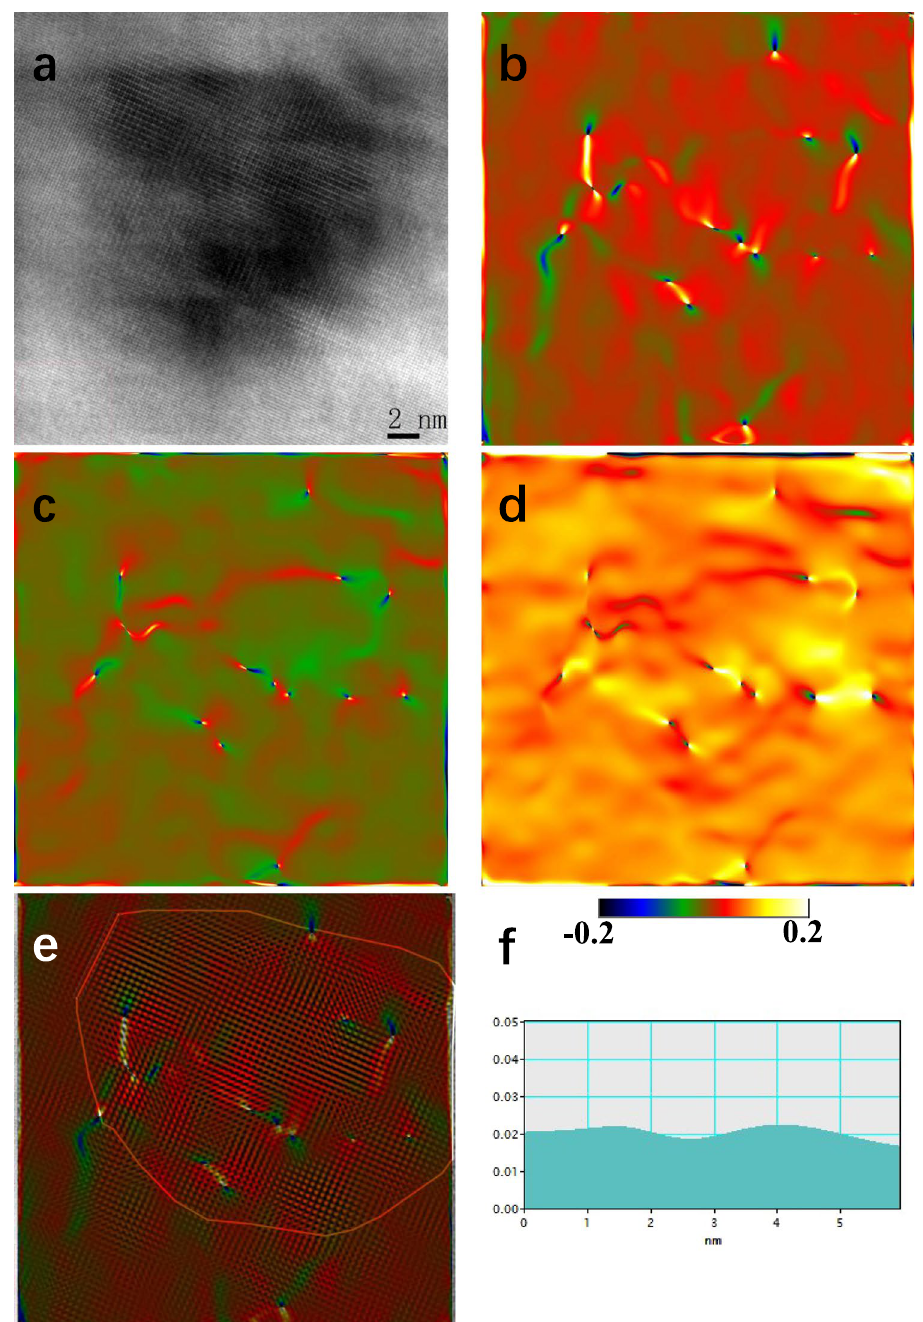
Figure 7. GPA of a semi-coherent Al 3 Zr precipitate in the III-type-400 Al-Zr conductor. ( a ) A representative HRTEM image to show a semi-coherent Al 3 Zr precipitate. Corresponding GPA results demonstrating the local ε strain field ( b ), ε strain field ( c ), and ε strain field ( d ). ( e ) Is a picture overlapping the GPA ε xx yy xy with the HRTEM image, where the Al 3 Zr precipitate/matrix interface is highlighted by a loop line. ( f ) Shows the distribution of ε in a profile that was measured along a segment (as marked by green box in ( e )) of the Al 3 Zr xx precipitate/matrix